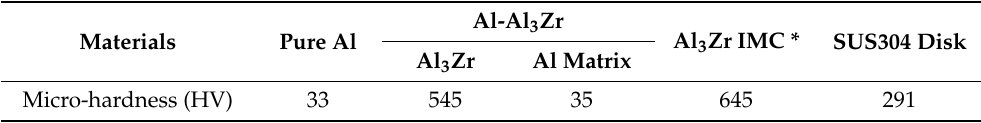
Table 1. Vickers micro-hardness values of pure Al, Al–Al 3 Zr composite, Al 3 Zr IMC, and SUS304 disc.